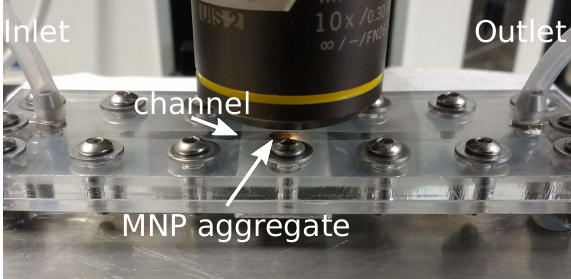
Figure 3. The photo shows the microfluidic device during a measurement. The MNP suspension continuously flowed thorough the channel from the inlet. A neodymium magnet was positioned under the center of the channel and the nanoparticles aggregated in its magnetic field. The aggregation procedure was monitored with a